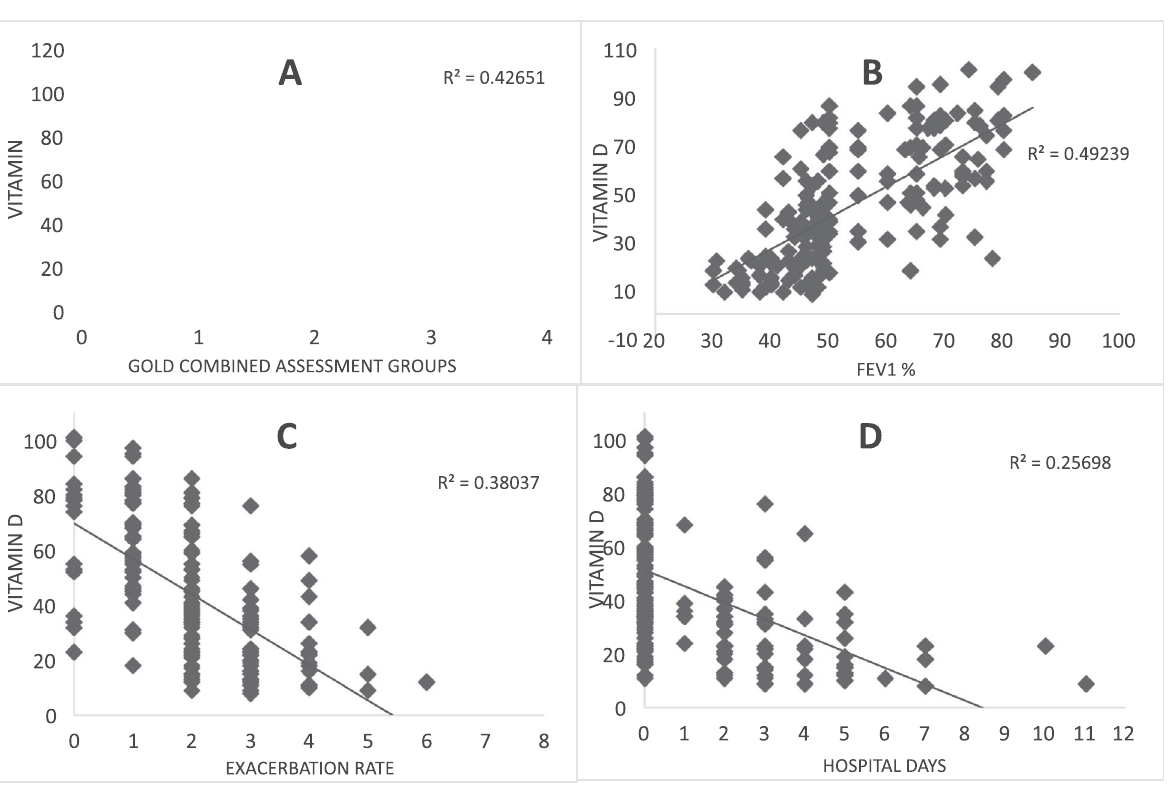
Levels of vitamin D in nmol/l plotted against (a) COPD GOLD groups (1 = GOLD A, 2 = GOLD B, 3 = GOLD C, and 4 = GOLD D), (b) against forced expiratory volume in first second (FEV1), (c) exacerbation rate, and (d) hospital days. P <